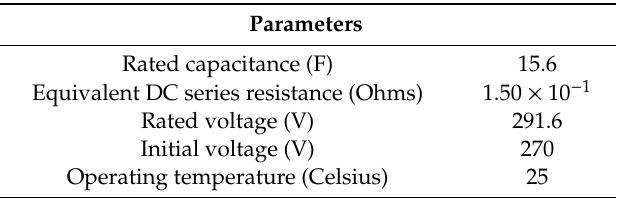
Table 5. Supercapacitor (SC) main parameters.